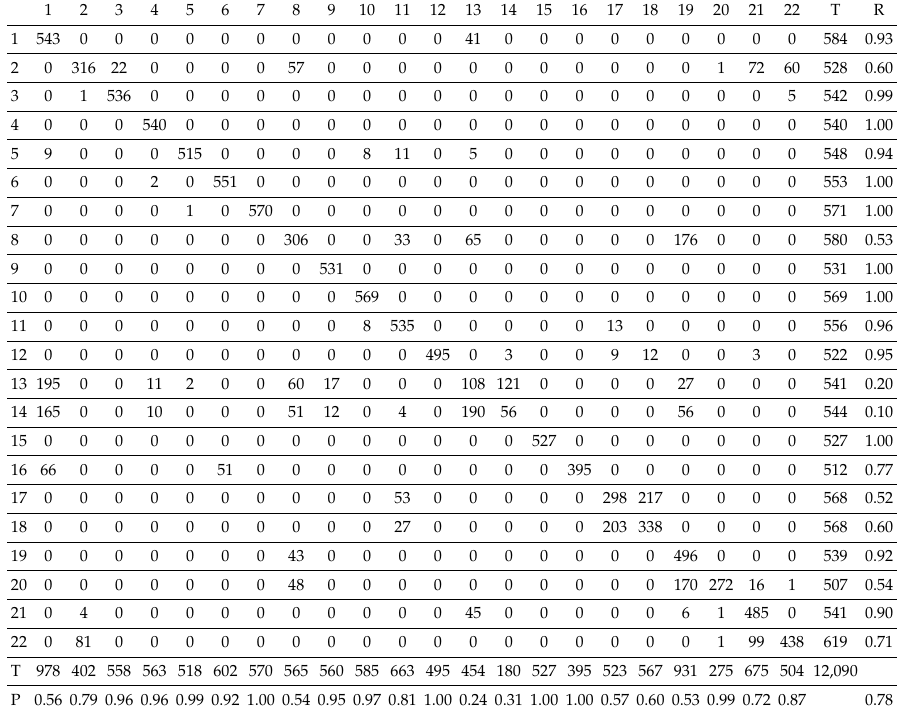
Table A2. The confusion matrix of the nearest-neighbor-based baseline without attributes’